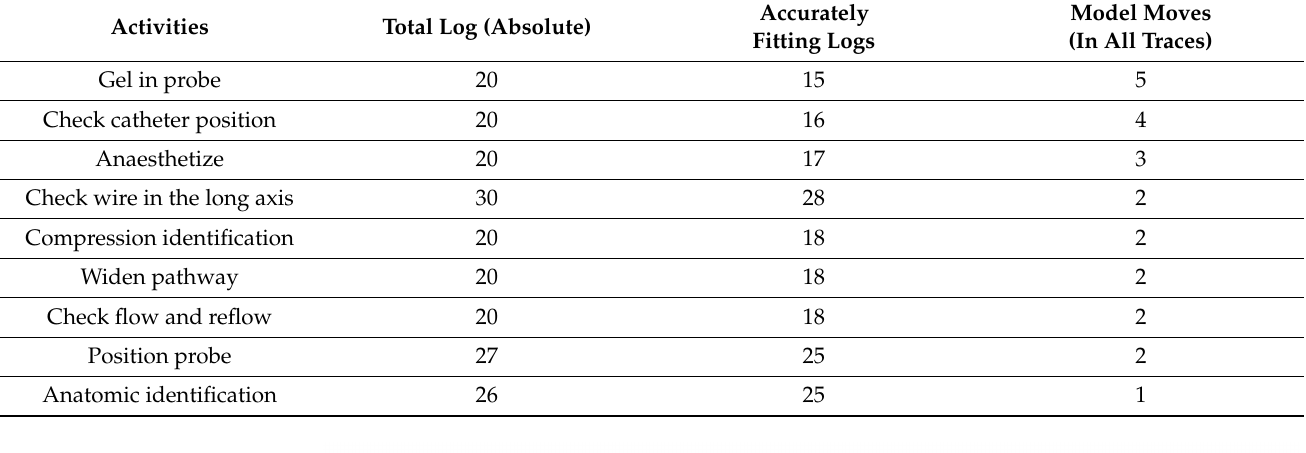
Figure 6. Trace fitness alignment value distribution. Table 2. Activity-based conformance check.